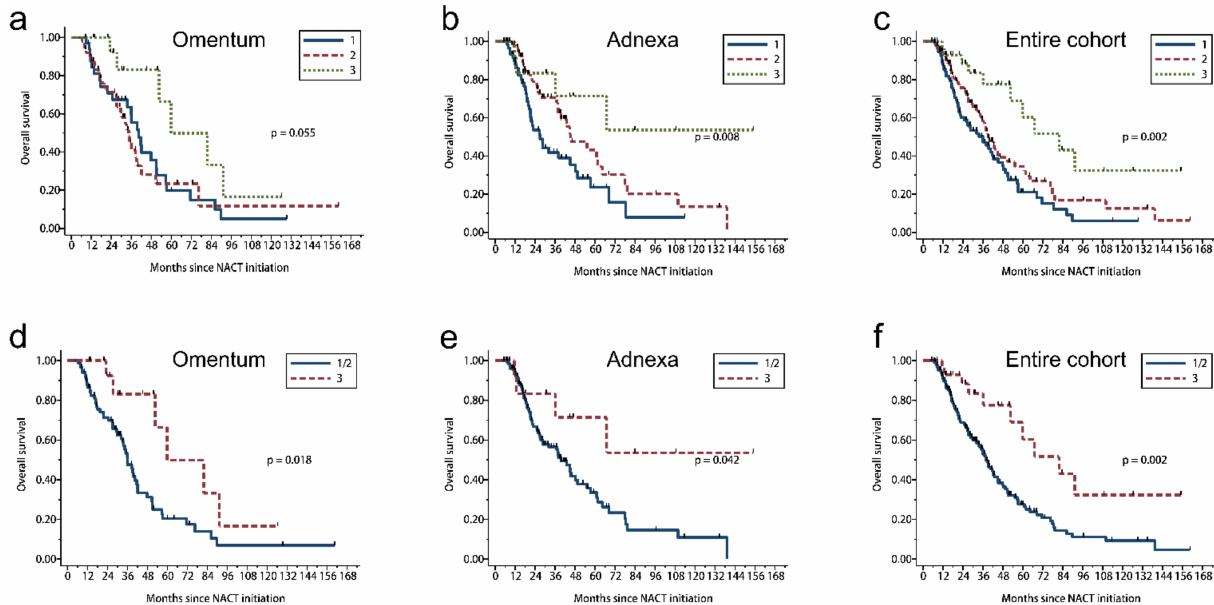
Figure 6. Kaplan–Meier estimates of OS according to CRS for the entire cohort and scoring site subgroups. ( a – c ) Three-tier CRS. ( d – f ) Modified 2 tier CRS (CRS 1 and 2 versus CRS 3).